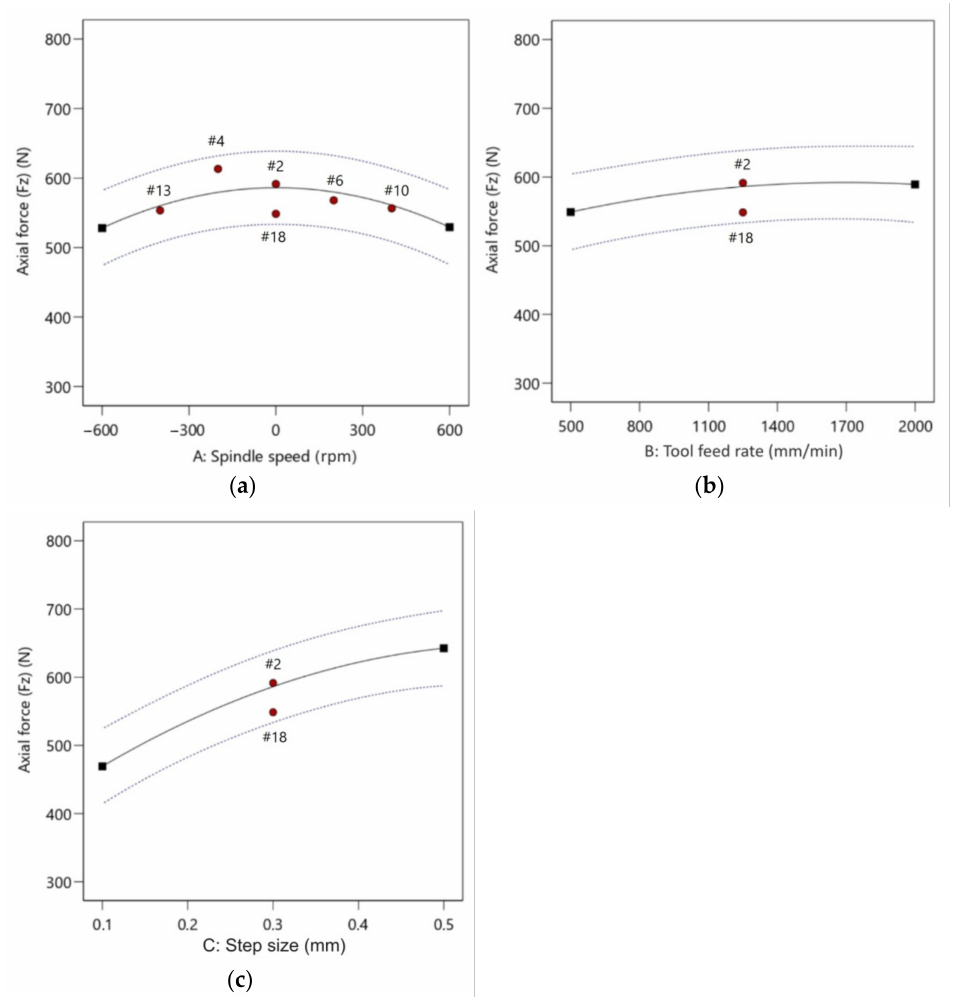
Figure 9. Plots showing the effect of: ( a ) spindle speed; ( b ) feed rate; and ( c ) step size on axial